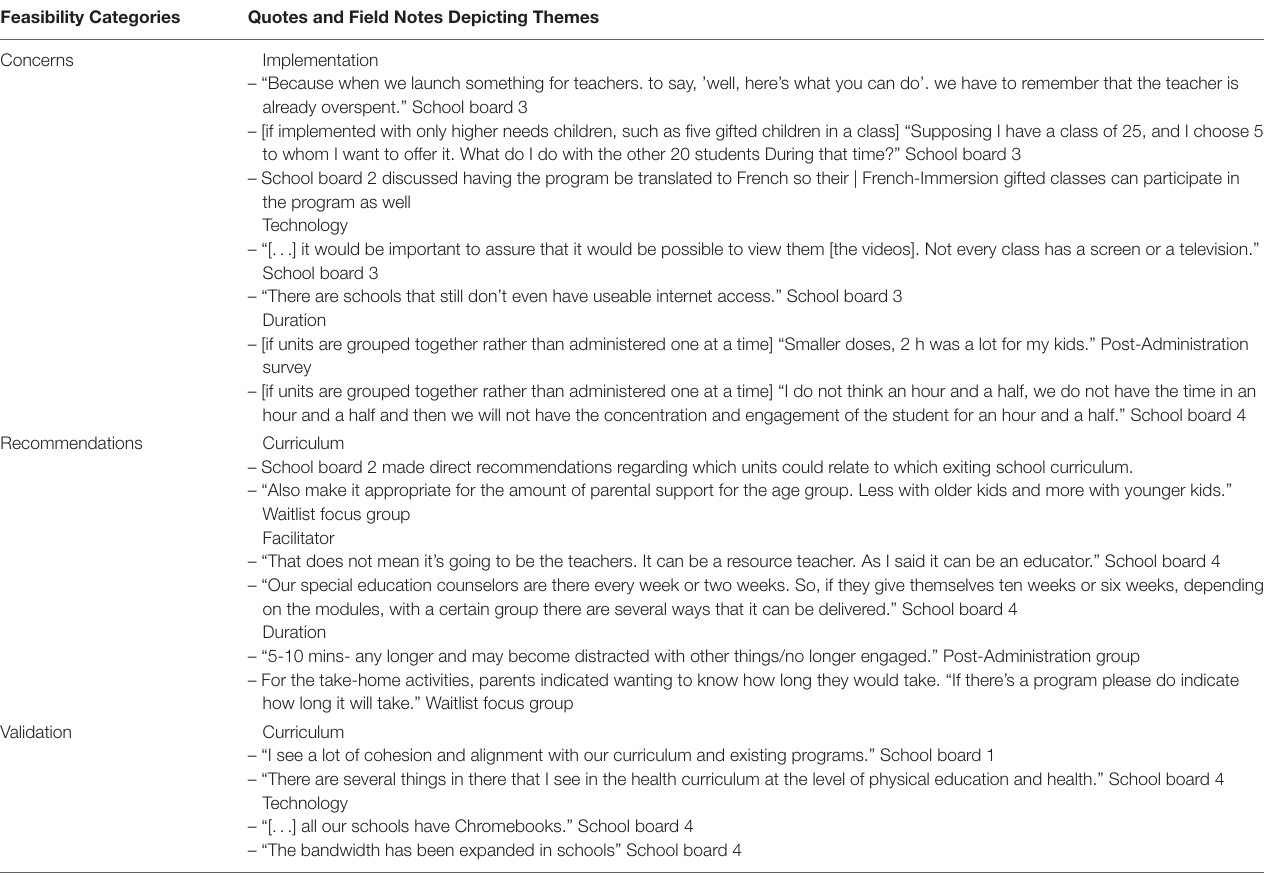
TABLE 3 | Feasibility qualitative